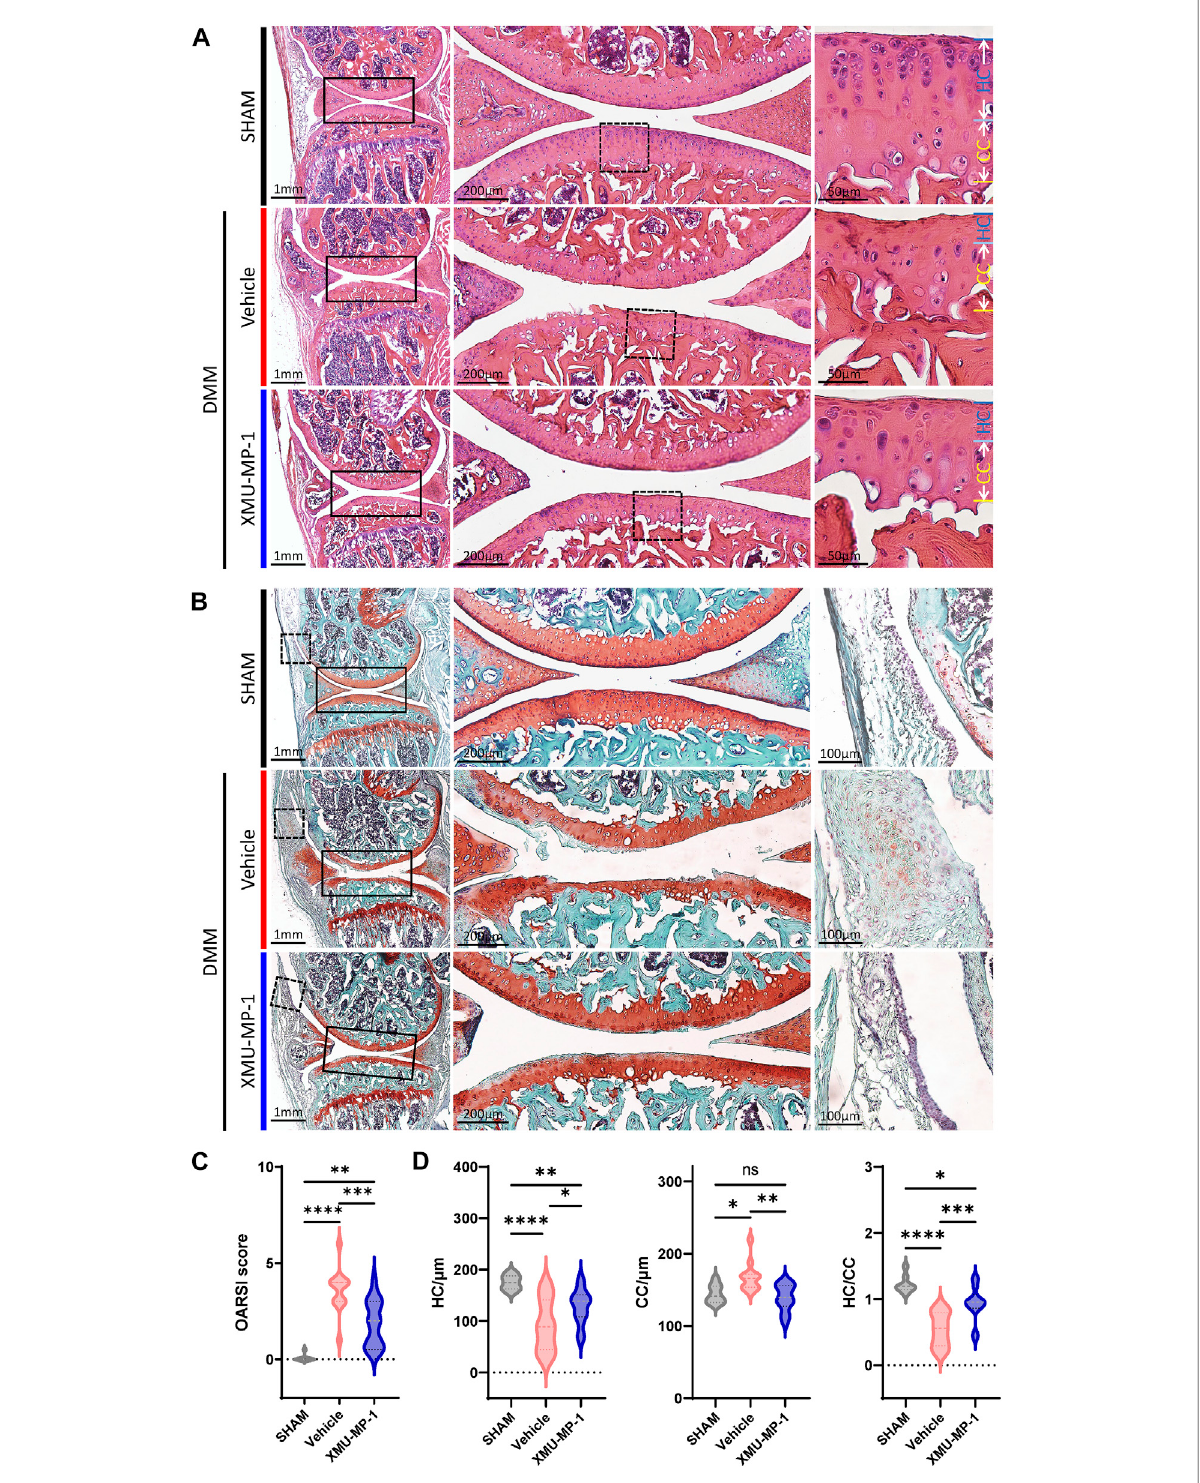
FIGURE 4 XMU-MP-1 alleviates articular cartilage degeneration during OA process. (A) Representative images of HE staining of knee joint sections from miceofindicatedgroups.SHAM:Miceunderwentshamsurgery.Vehicle:MiceundergoingDMMsurgerywereintraperitoneallyinjectedwithvehicle. XMU-MP-1: Mice undergoing DMM surgery were intraperitoneally injected with XMU-MP-1. Panels in the middle are high magni fi cations of boxed regions in the left panels; panels on the right are high magni fi cations of boxed regions in the middle panels. (B) Representative images of